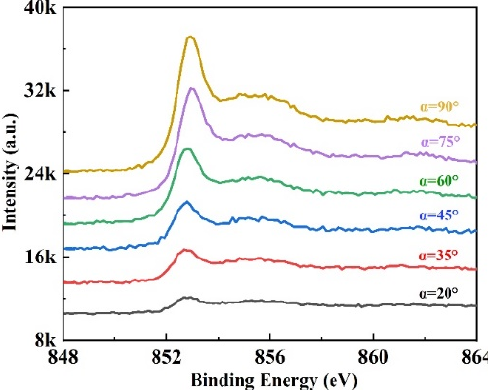
Table 2. Relative peak intensities ( I s and I o ) and the I o / I s ratios for both nickel oxides in the NiFe (100 nm) thin film.